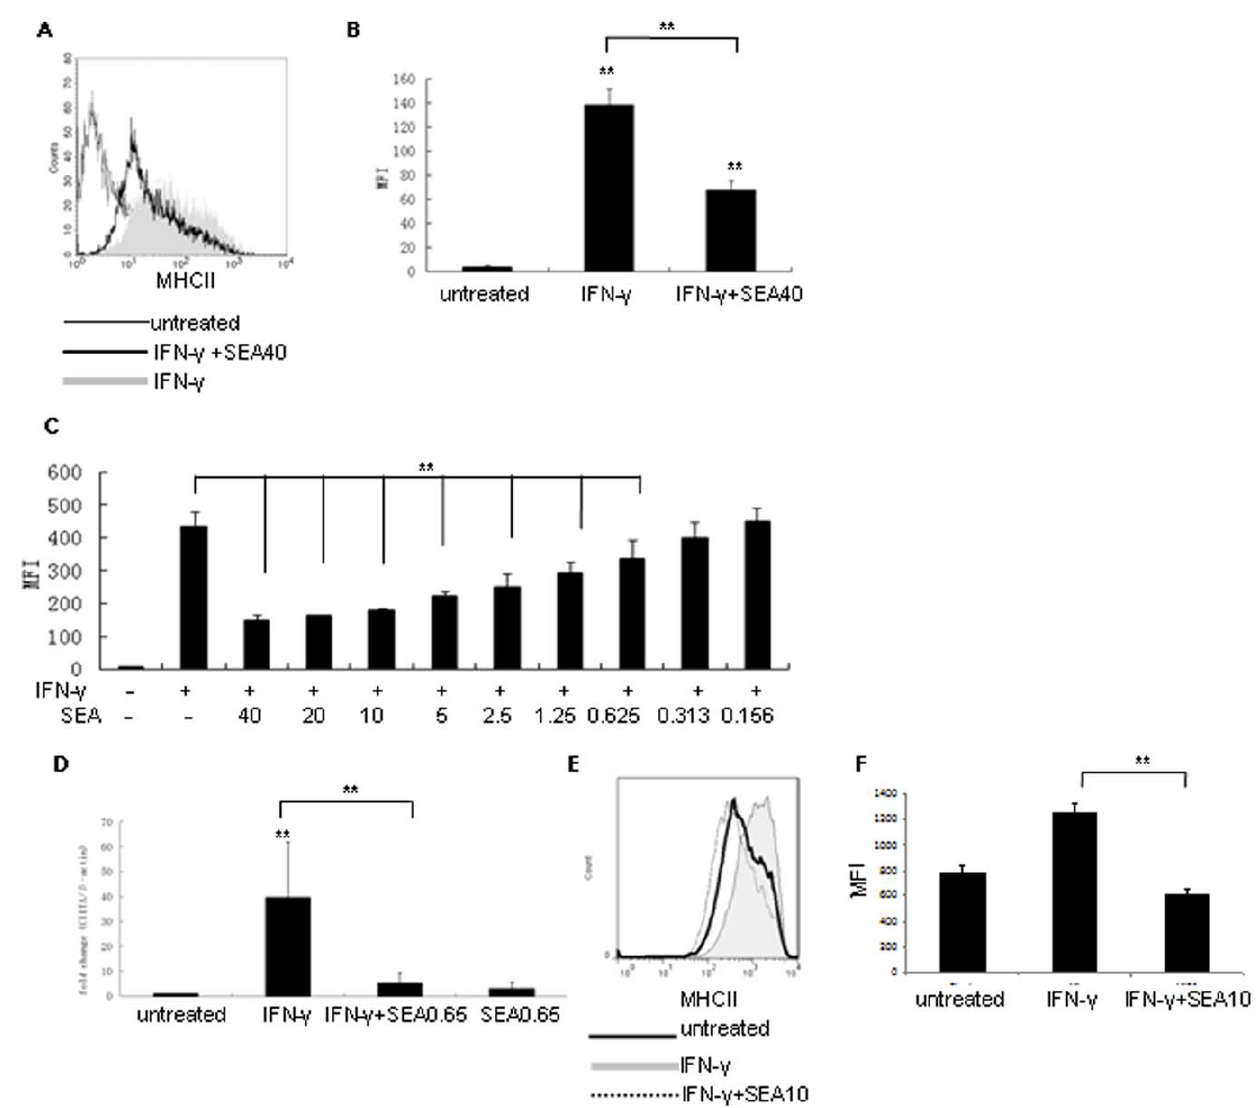
Figure 1. SEA attenuated MHC class II expression in RAW 264.7 cells. (A) Flow cytometric analysis of MHC class II expression in RAW 264.7 cells stimulated with IFN- c (shaded histogram), 40 m g/ml of SEA (SEA40) and IFN- c simultaneously (open histogram with thick line) and untreated cells (open histogram with thin line). (B) Histogram showing the mean fluorescence intensity (MFI) of MHC class II expression in RAW 264.7 cells stimulated with IFN- c , 40 m g/ml of SEA (SEA40) and IFN- c simultaneously and cells cultured with medium alone (untreated). (C) Histogram showing the mean fluorescence intensity (MFI) of MHC class II expression in RAW 264.7 cells stimulated with IFN- c and serially diluted SEA from 40 m g/ml to 0.156 m g/ml simultaneously, or with IFN- c alone, or with medium alone for 48 h. (D) Fold change of CIITA mRNA relative to b -actin mRNA in RAW 264.7 cells stimulated with IFN- c , 0.65 m g/ml SEA (SEA0.65), or IFN- c and 0.65 m g/ml SEA simultaneously (IFN- c + SEA0.65), cells cultured with medium alone (untreated) were used as control. (E) Flow cytometric analysis of MHC class II expression in RAW 264.7 cells stimulated with IFN- c (R&D) (shaded histogram), 10 m g/ml of SEA (SEA10, treated with endotoxin removing gel, endotoxin level is 0 EU/ml) and IFN- c simultaneously (open histogram with dotted line) and untreated cells (open histogram with thick line). (F) Histogram showing the mean fluorescence intensity (MFI) of MHC class II expression in RAW 264.7 cells stimulated with 10 ng/ml IFN- c (R&D), 10 m g/ml of SEA (SEA10, treated with endotoxin removing gel, endotoxin level is 0 EU/ml) and IFN- c simultaneously and cells cultured with medium alone (untreated). (** P , 0.01). IFN- c were used as control. Following, the pretreated supernatants neously led to significant up-regulation of MHC class II and control medium were used for culturing RAW 264.7 cells for expression. These results suggested that IL-10 might play a more 48 h. At the end of culture, MHC class II expression was detected important role than IL-6 in mediating the suppression of MHC by flow cytometry. The results indicated that neutralization of IL- class II expression by SEA. 10 (Figure 3A, 3B) or IL-6 (Figure 3C, 3D) in the supernatants of RAW 264.7 cells primed with 40 m g/ml of SEA and IFN- c simultaneously both resulted in significant up-regulation of MHC class II expression ( P , 0.01). Neutralization of IL-10 (Figure 3E, 3F) but not IL-6 (Figure 3G, 3H) in supernatants of RAW